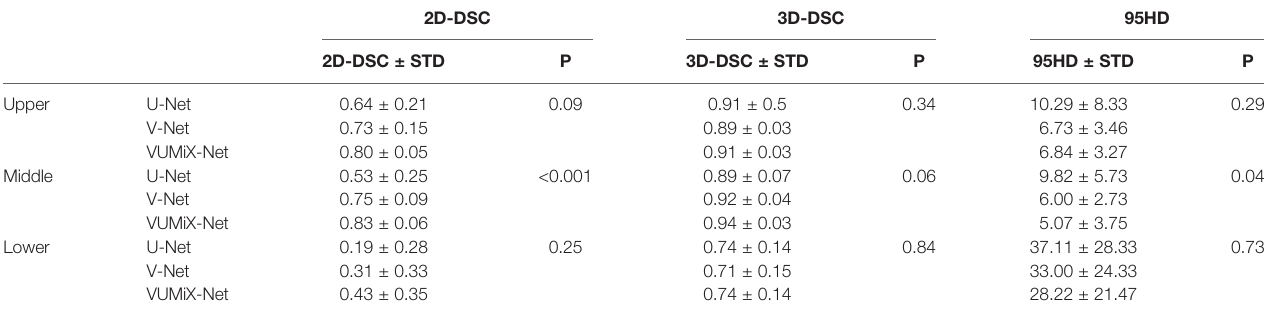
TABLE 4 | 2D-DSC, 3D-DSC, and 95HD values of the GTV contours in upper EC, middle EC, and lower EC patients predicted from U-Net, V-Net, and VUMix-Net.